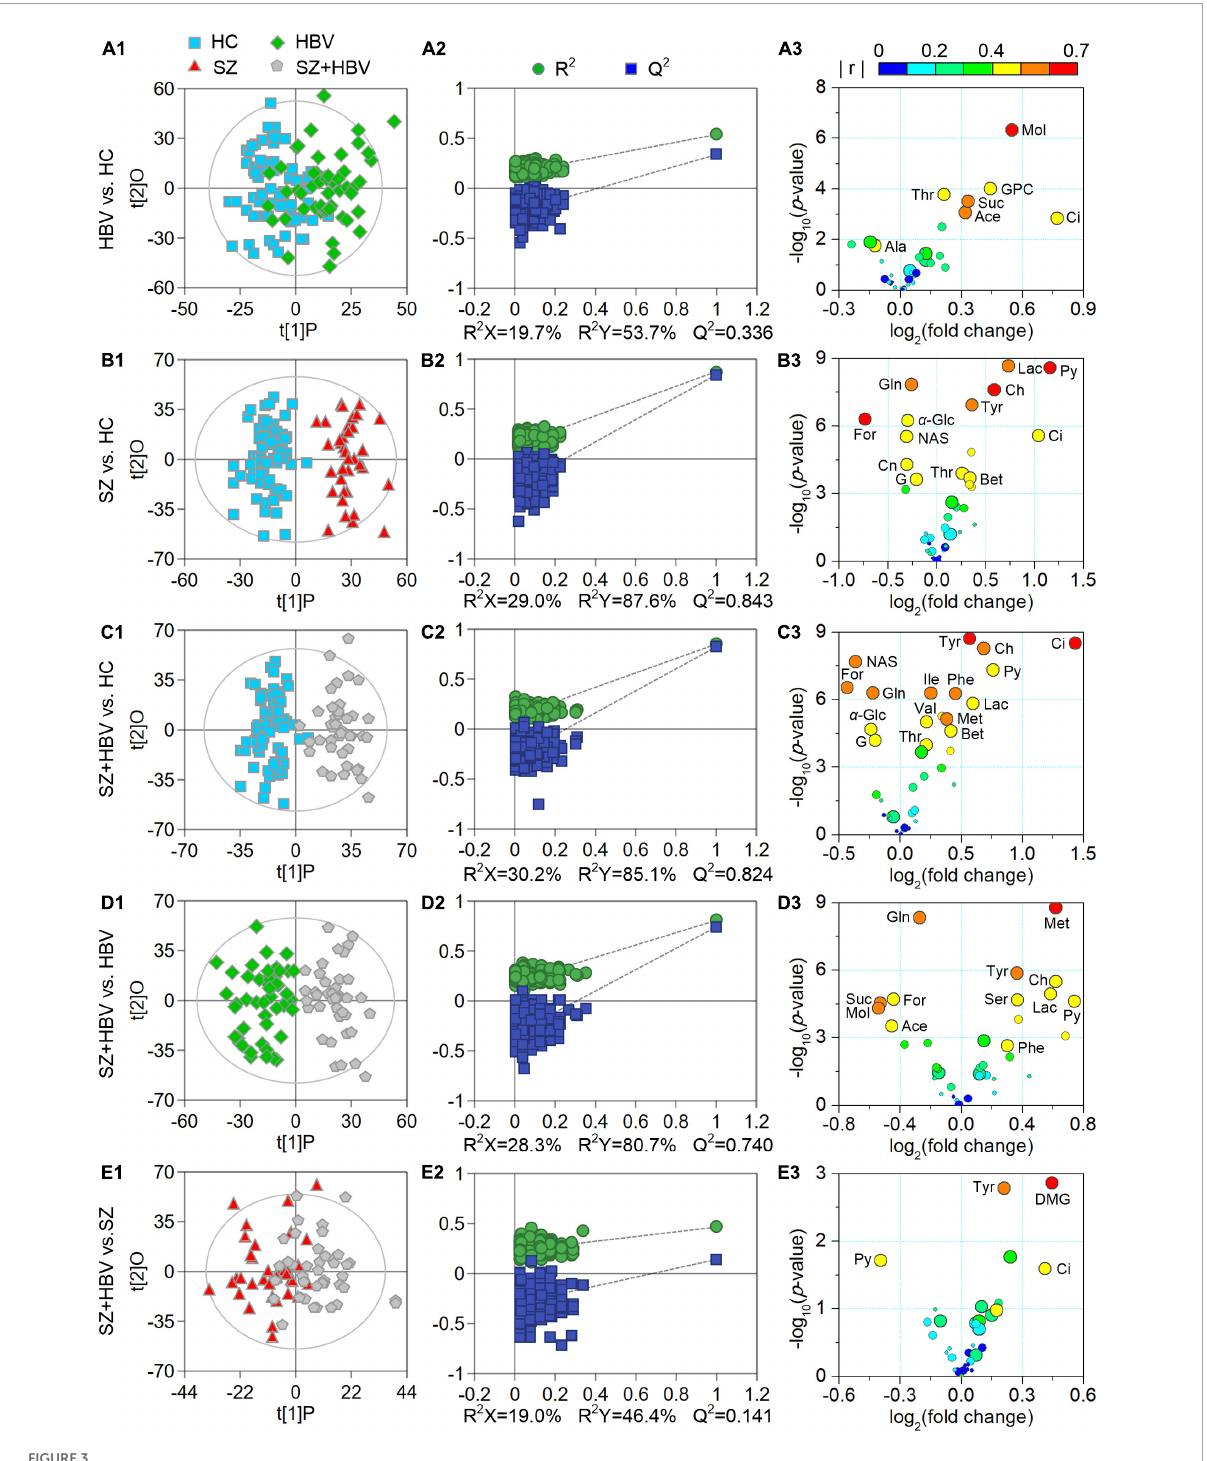
FIGURE3 Score plots (A1–E1) , permutation test results (A2–E2) , and volcano plots (A3–E3) derived from different orthogonal partial least-squares discriminant analysis (OPLS-DA) models. In the volcano plots, circles in different sizes and colors denote variable importance projection (VIP) and | r | values, respectively. VIP values are categorized into three levels: VIP > 1.0, 1.0 ≥ VIP > 0.7, and VIP ≤ 0.7 represented by circles with decreasing diameters. Colors varying from blue to red indicate the | r | values from 0 to 1. Characteristic metabolites were identified by the following criteria: P -value < 0.05, VIP > 1. 0, and | r | >